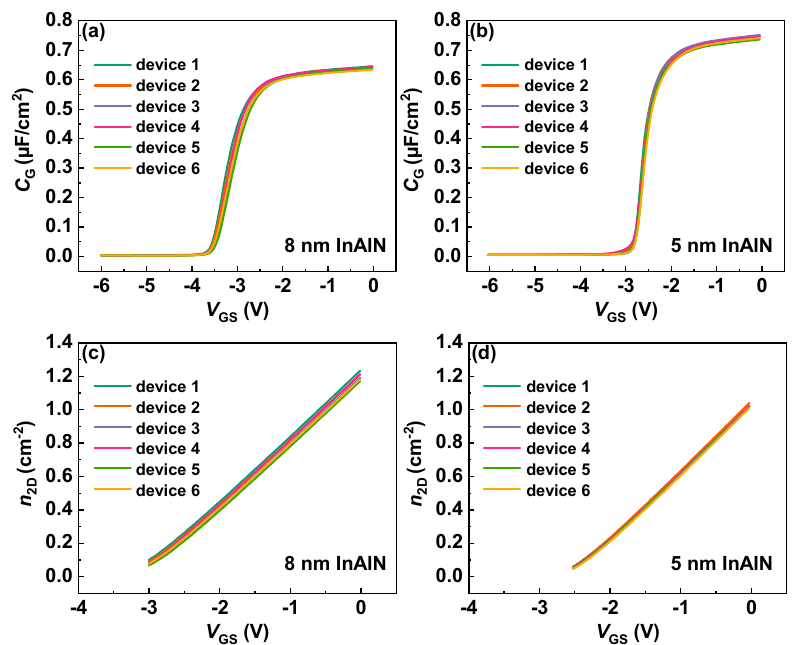
Figure 2. Gate capacitance ( C G ) of the InAlN/GaN diode with ( a ) 8 nm InAlN and ( b ) 5 nm InAlN, respectively. Two-dimensional electron gas electron density ( n 2D ) of the InAlN/GaN diode with ( c ) 8 nm InAlN and ( d ) 5 nm InAlN, respectively.